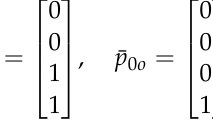
based on regression. The input of the network is the image patch X defined by a bounding box from the object detection phase. The output is a vector of position coefficients ˆ y